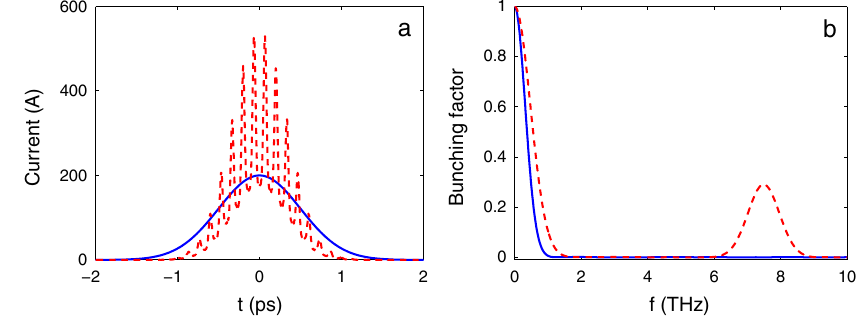
FIG. 8. (Color) (a) Initial current distribution (solid blue line) and that after the dispersion section (dashed red line). (b) Corresponding bunching factor for the initial current distribution (solid blue line) and that after the dispersion section (dashed red